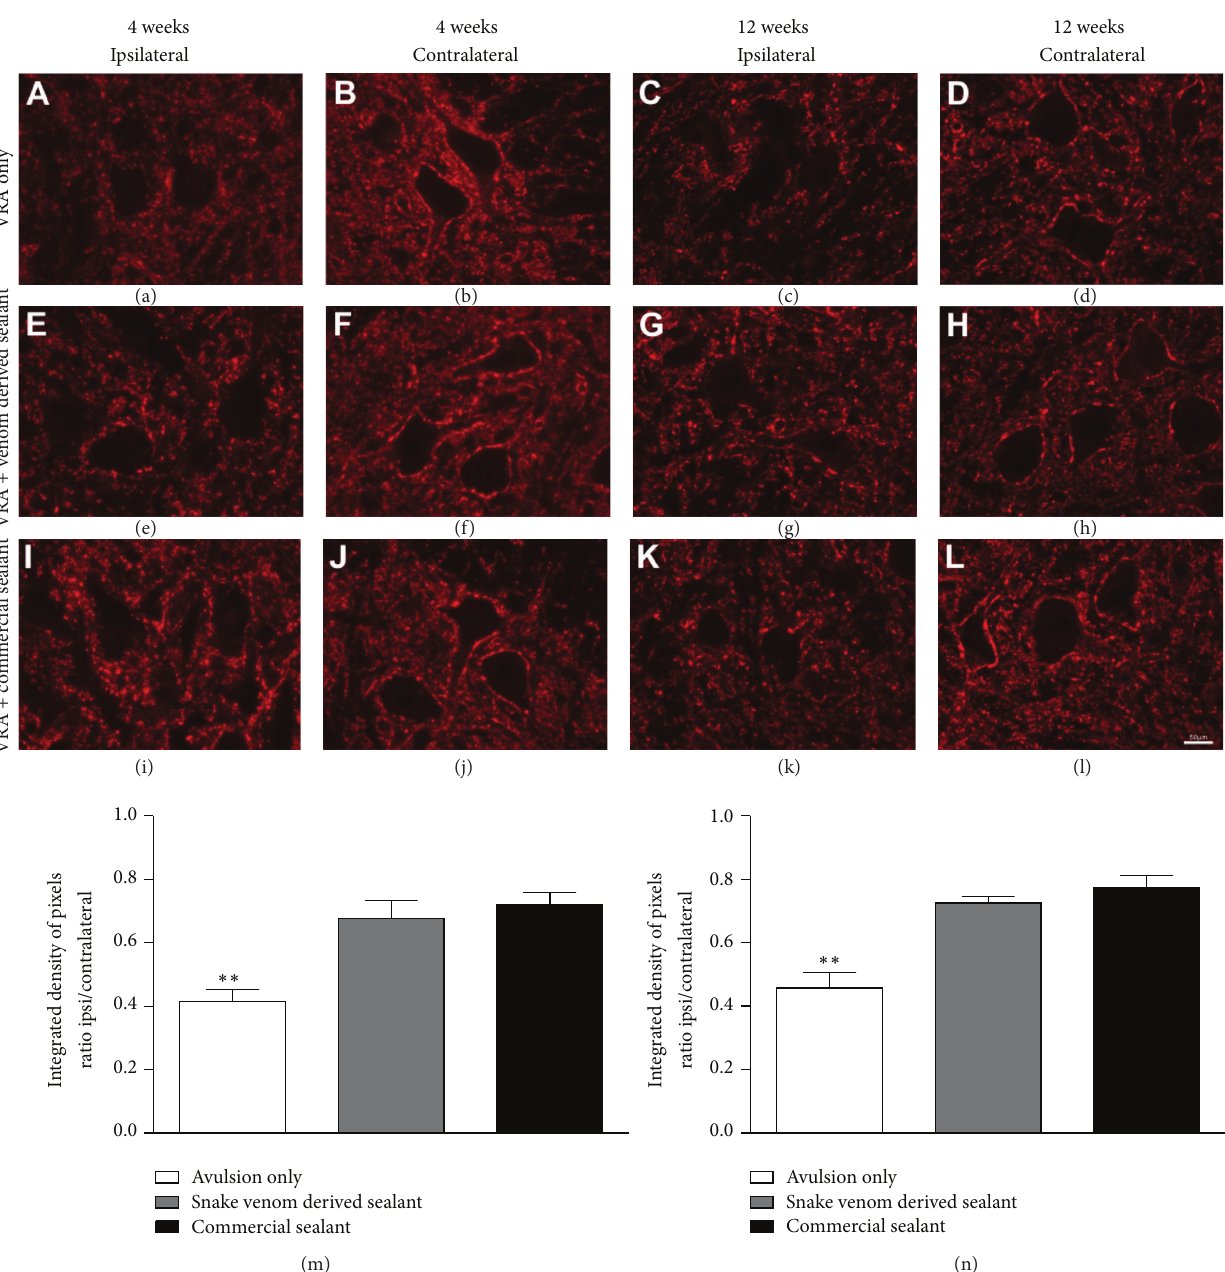
Figure 2: Immunohistochemical analysis of the spinal cord ventral horn stained with antisynaptophysin, 4 and 12 weeks, following ventral root avulsion and repair. A significant preservation of synaptophysin immunoreactivity was observed in both reimplanted groups. (a-b, e-f, and i-j) Ipsilateral and contralateral sides, 4 weeks after lesion. (c-d, g-h, and k-l) Ipsilateral and contralateral sides, 12 weeks after lesion. (m) Synaptic covering, obtained by the ratio IL/CL (ipsi/contralateral sides) of the integrated density of pixels at lamina IX, 4 weeks after lesion. (n) Synaptic covering, obtained by the ratio IL/CL (ipsi/contralateral sides) of the integrated density of pixels at lamina IX, 4 weeks after lesion. Observe the significant reduction of synaptic elimination in both groups repaired with fibrin sealant. Scale bar = 50 𝜇 m. Mean ± SE. ∗∗ 𝑝 < 0.01